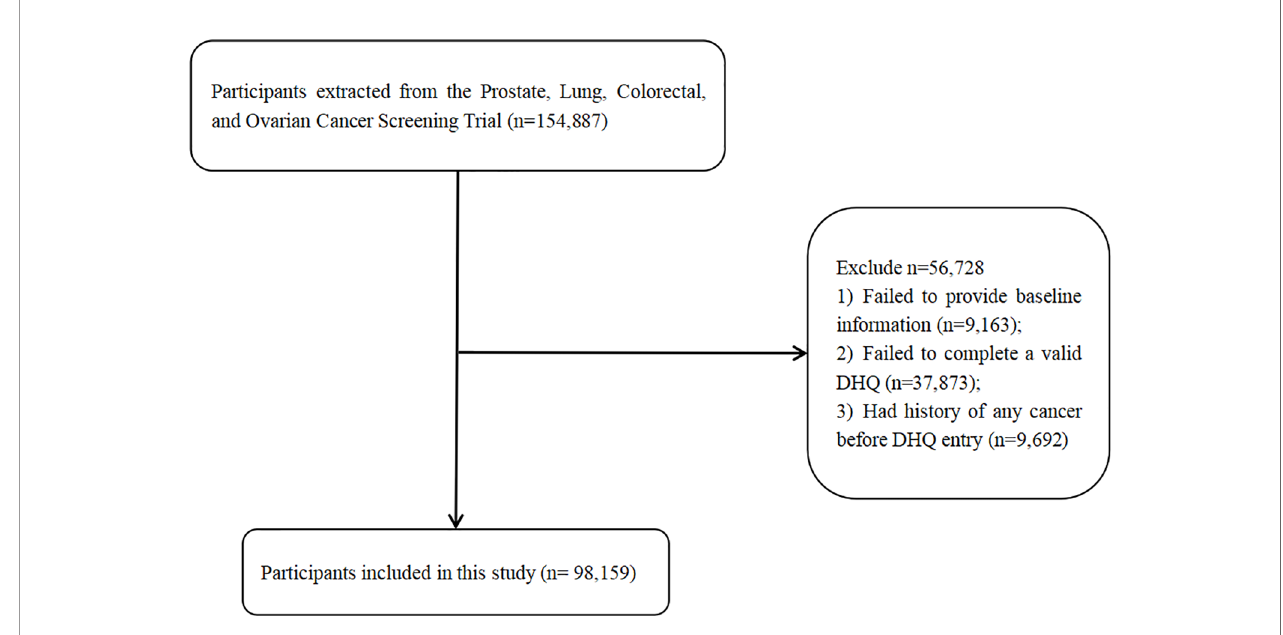
FIGURE 1 | Flow diagram of the selected